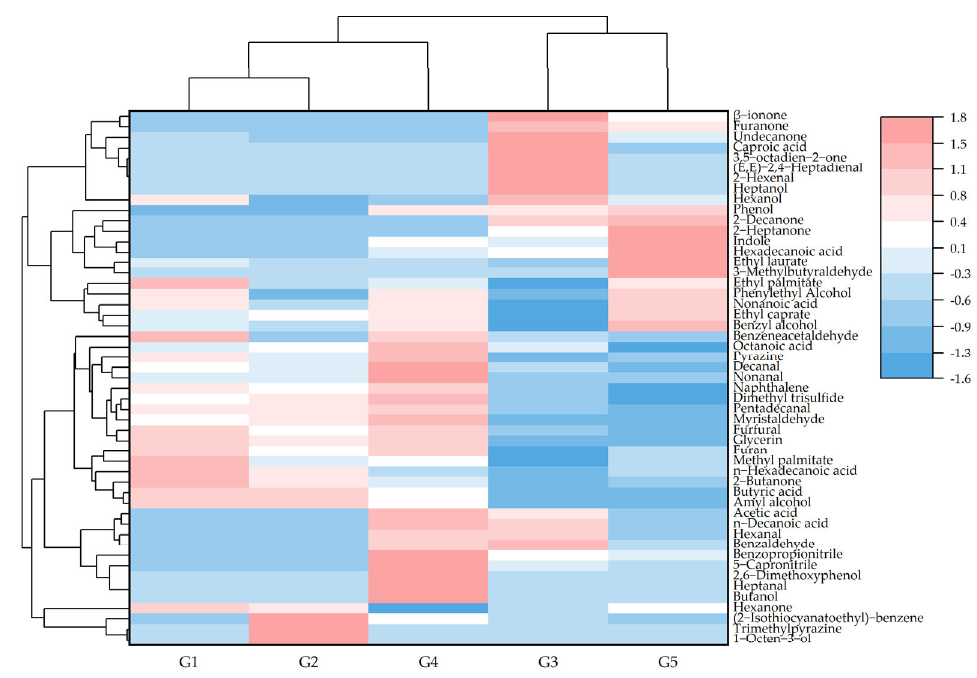
Figure 5. Cluster analysis of pickled BLS with different salt concentrations.